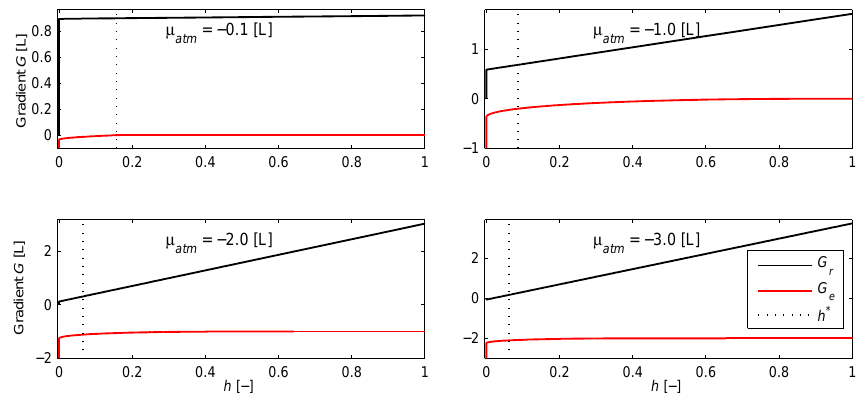
Figure 1. The gradients driving evaporation ( G e ) and run-off ( G r ) as a function of the relative saturation ( h ) for different values of µ atm with k r = k ∗ r . At h = 0, the slope of the gradient G e is vertical, while the value of G r is set to zero to avoid run-off at zero saturation.